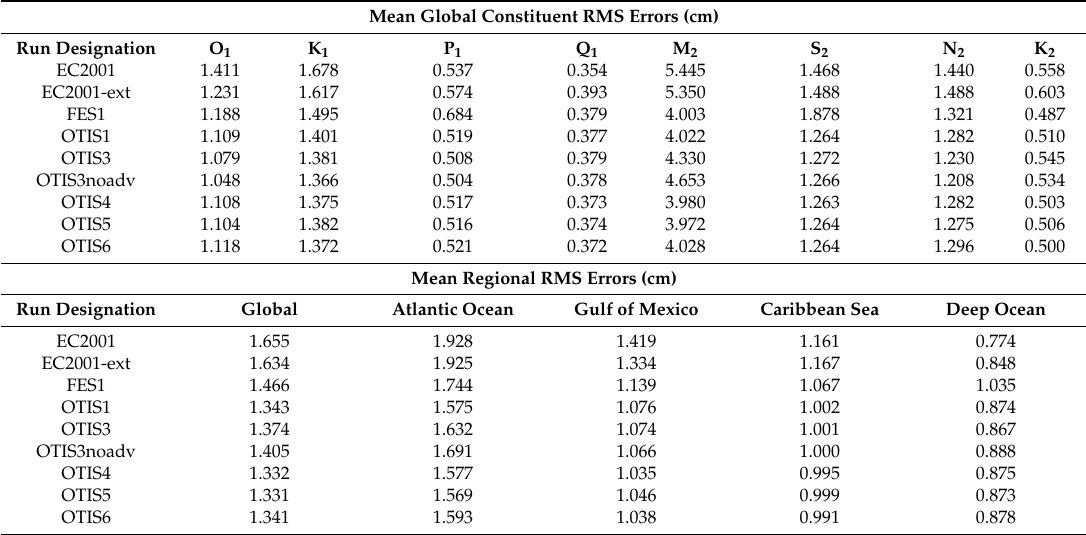
Table 8. Summary of RMS errors (cm) for the 367 common validation stations: global means for